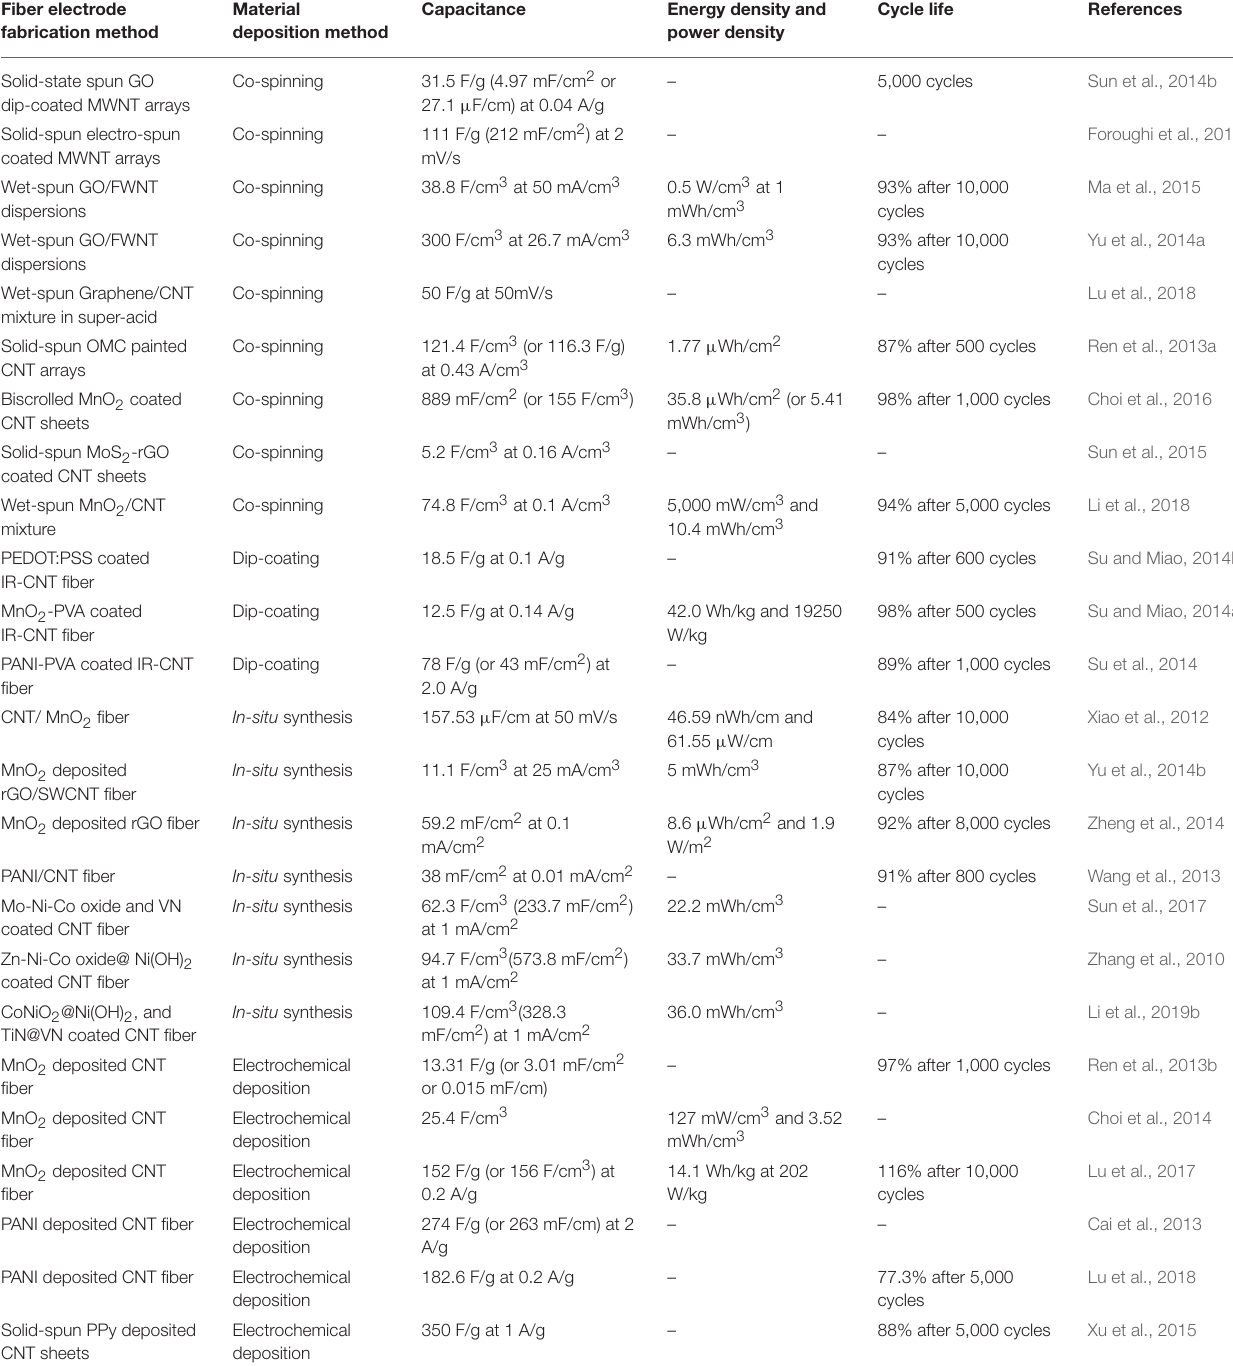
TABLE 2 | Electrochemical performances of CNT fiber-based electrodes and supercapacitors in different fabrication and deposition